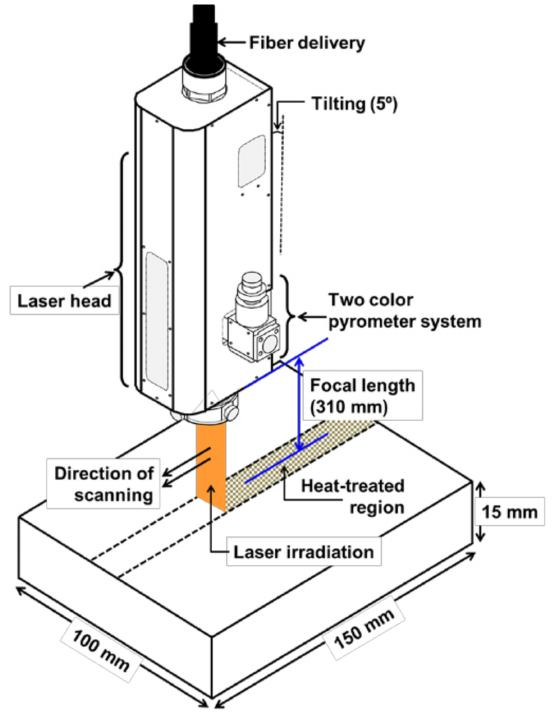
Figure 1. Schematic description of specimen arrangement and laser-assisted heat